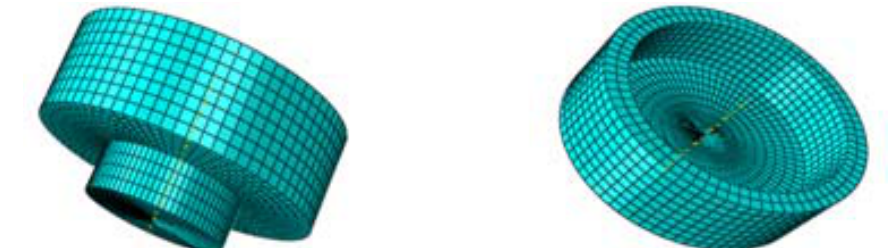
Figure 12: joint geometry and Mesh (contact zone)